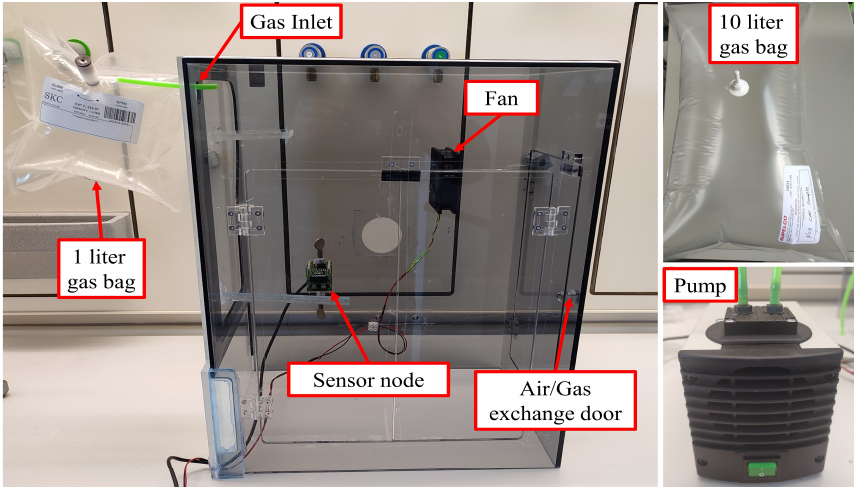
Figure 5. The used gas testing chamber, 10 L gas sample bag, and small pump.